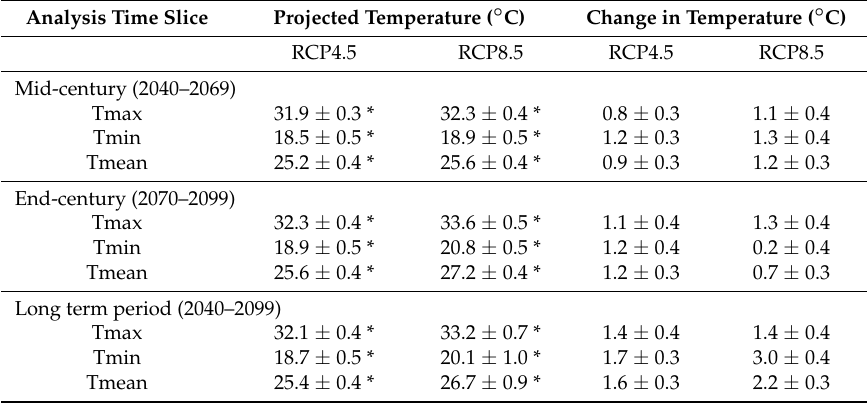
Table 5. Future projected temperatures in Karamoja sub-region.